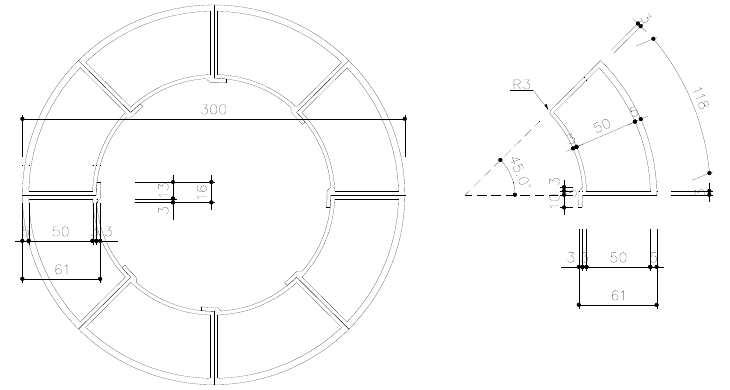
Figure 6. Cross-section of the hybrid-FRP.